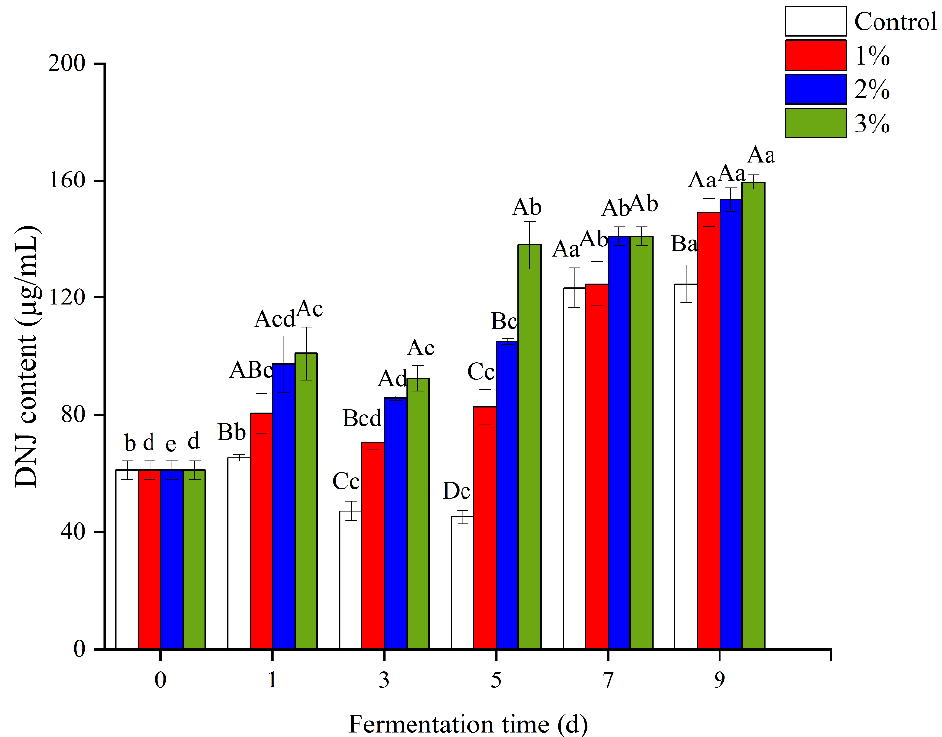
Figure 1. Changes in the 1-deoxynojirimycin (DNJ) content in the fermented alcoholic beverages during fermentation. Values followed by uppercase letters indicate significant differences in added concentration, lowercase letters indicate significant differences in fermentation time ( p < 0.05). Control represents without the addition of mulberry leaves; 1, 2 and 3% ( w / v , g/mL dry weight) represent the added amount of mulberry leaf powder.